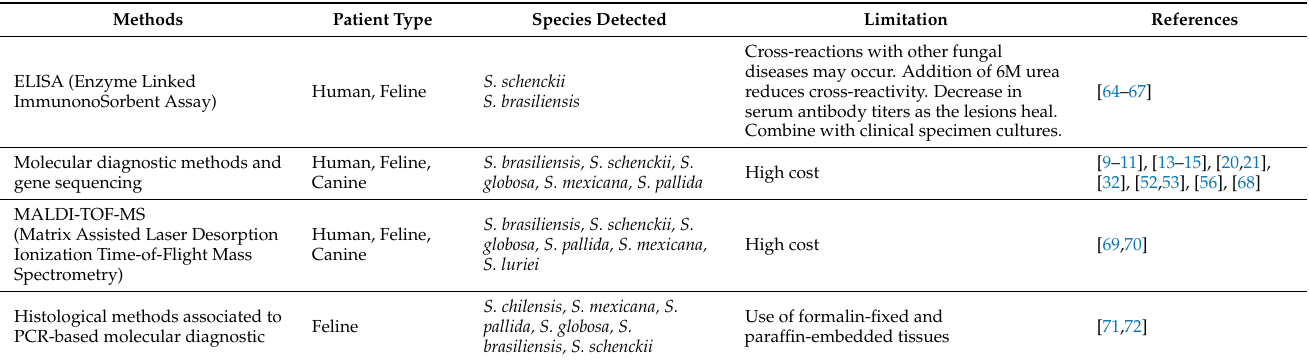
Table 3. Immunological (serodiagnostic), molecular, spectrometric and combination diagnostic methods used for the diagnosis of